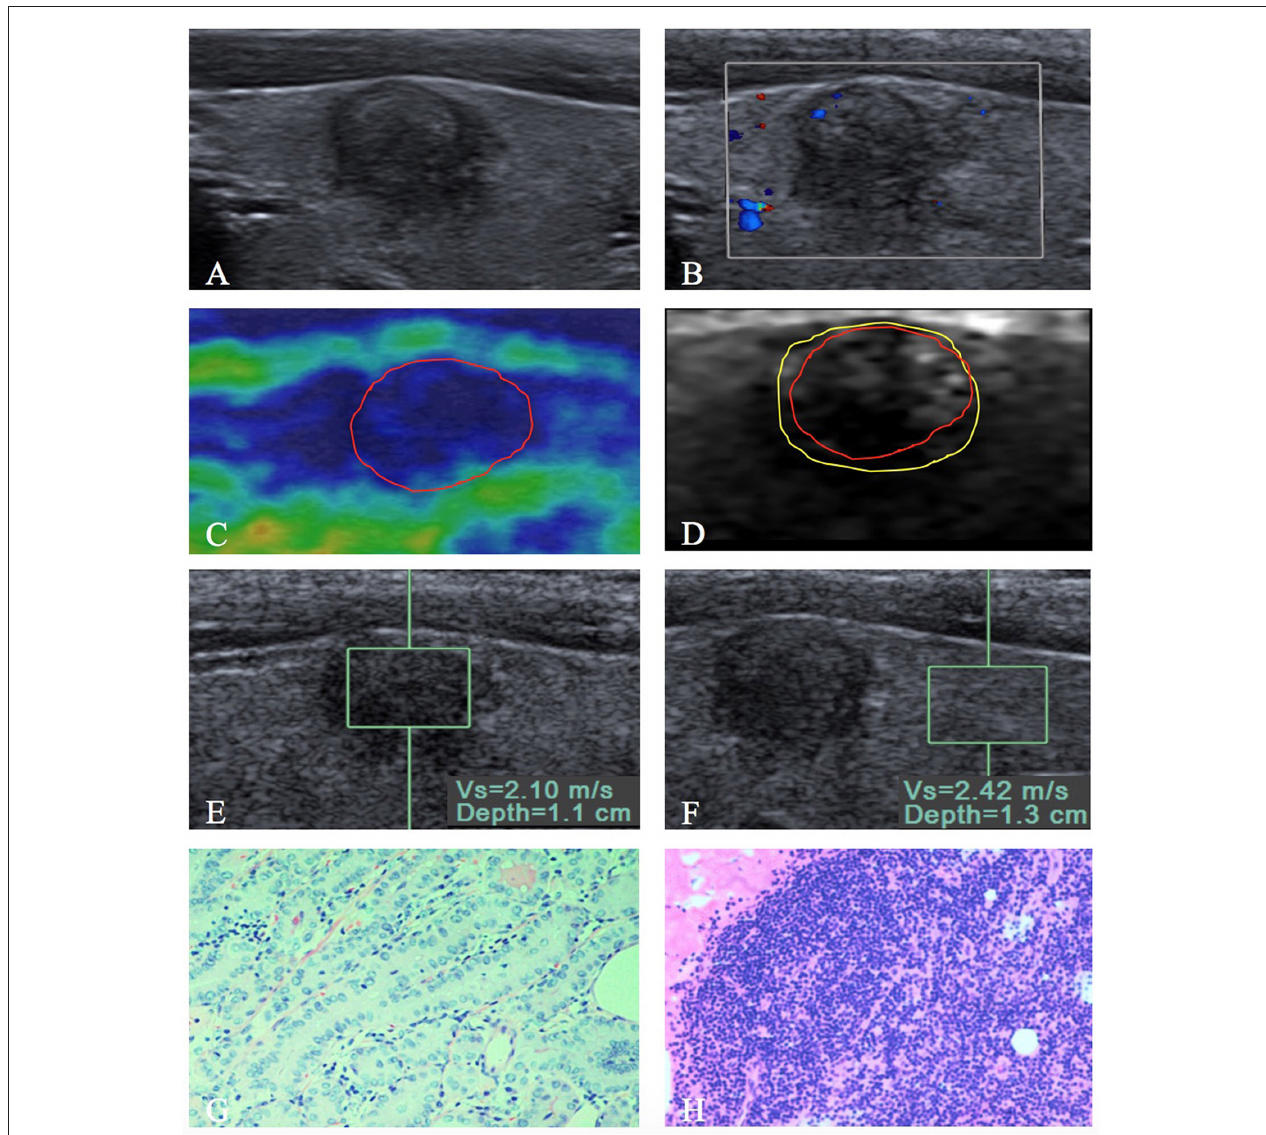
FIGURE 3 | A 9mm papillary thyroid carcinoma in a 35-year-old woman. (A) US image show that the tumor is in contact with the adjacent thyroid capsule, and there is halo sign present. (B) Rare intranodular flow is found on color Doppler flow imaging of the tumor. At elastography, (C) EI score is defined as 4 (red solid line). (D) VTI grade is defined as IV (yellow solid line), and the VTI area radio (line yellow /line red ) is 1.21. (E,F) SWV of 2.10 m/s is displayed on VTQ, and the VTQ ratio (SWV E /SWV F ) is 0.87. (G) PTC was confirmed by pathology (hematoxylin–eosin stain, × 200 magnification). (H) PTC without extrathyroidal extension (hematoxylin–eosin stain, ×